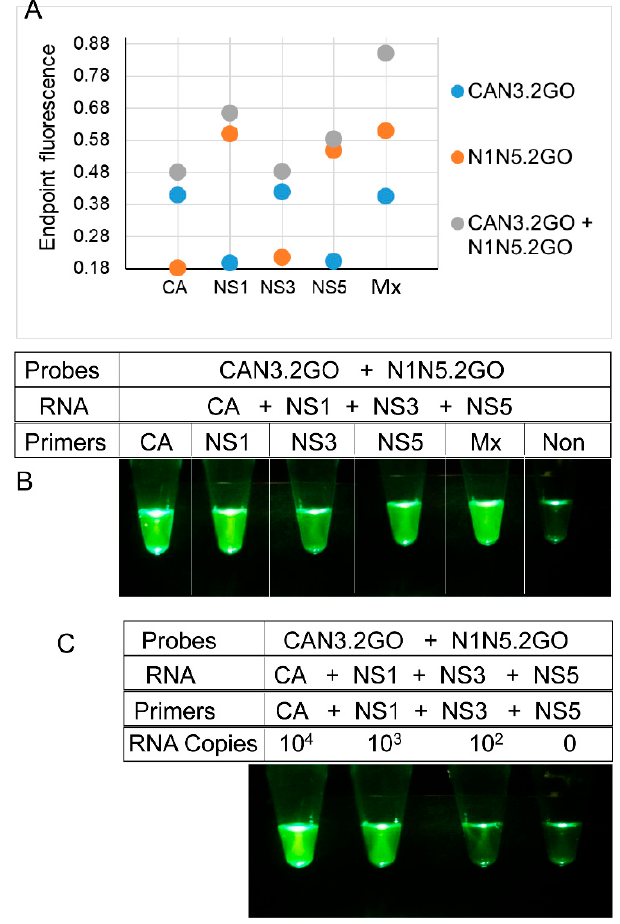
Figure 6. Detection of ZIKV RNA using two-input 2GO probes and degenerate reverse transcription LAMP. ( A ) Sequence-dependent activation of 2GO probes—synthetic RNA mixtures of 10 6 copies